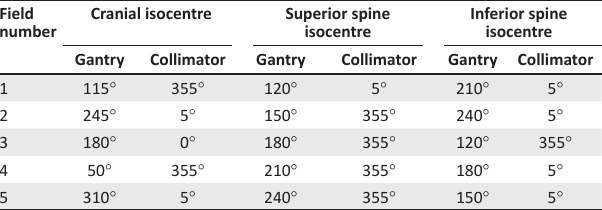
TABLE 1: Intensity-modulated radiation therapy gantry and collimator angles per field per isocentre. Field Cranial isocentre number